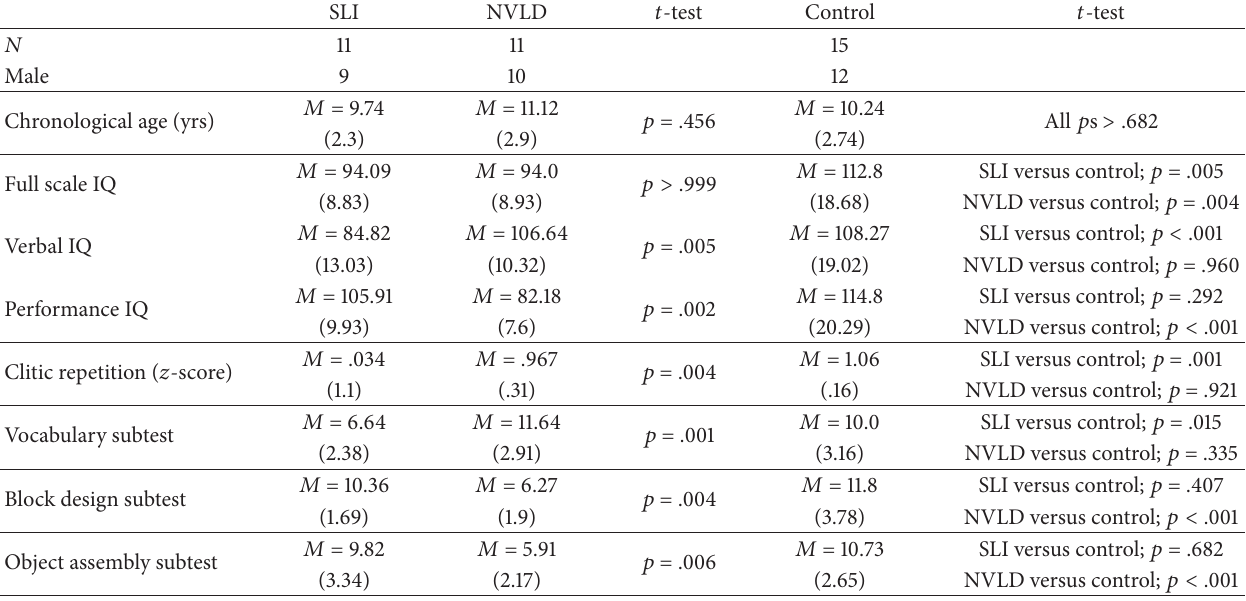
Table 1: Characteristics of participants included in the behavioral experiment. Standard deviations in parentheses.